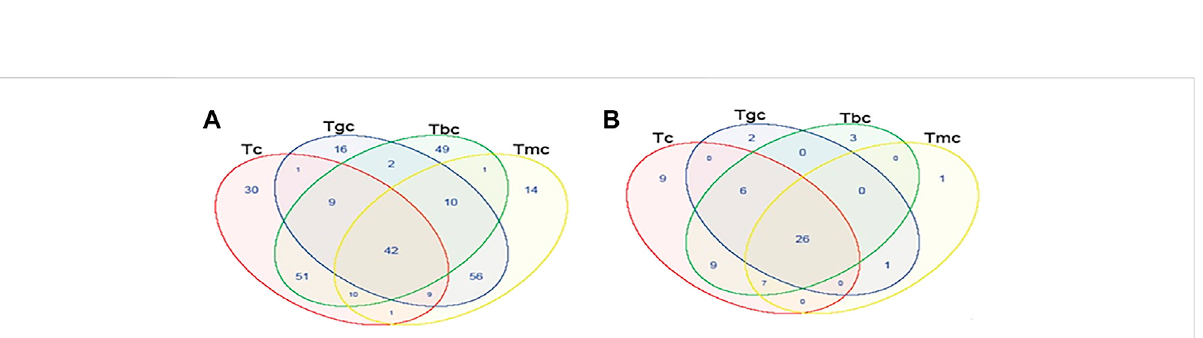
FIGURE 4 SharedOTUanalysisofthetreatedandcontrolgroups.VenndiagramshowingtheuniqueandsharedOTUs(3%distancelevel)intheprobiotic- treatedandcontrolgroups. (A) Venndiagramrepresentsthesharedanduniquebacterialcommunityamonggroups. (B) Venndiagramrepresentsthe shared and unique fungal community among